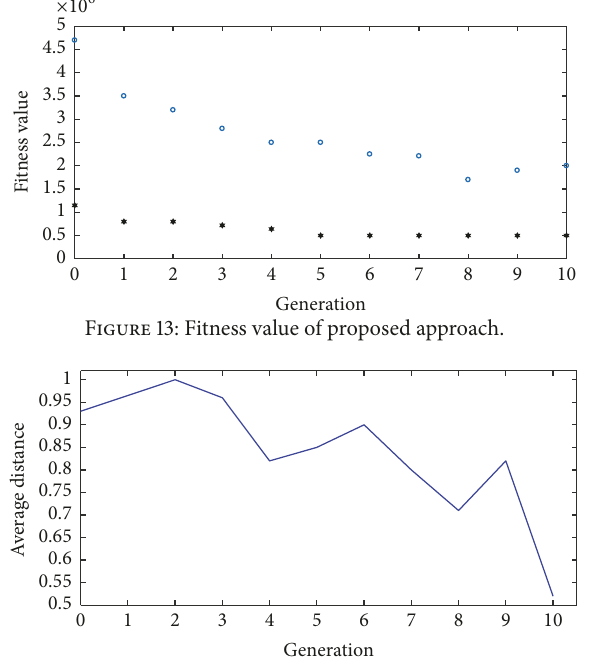
Figure 14: Average distance between individuals values.